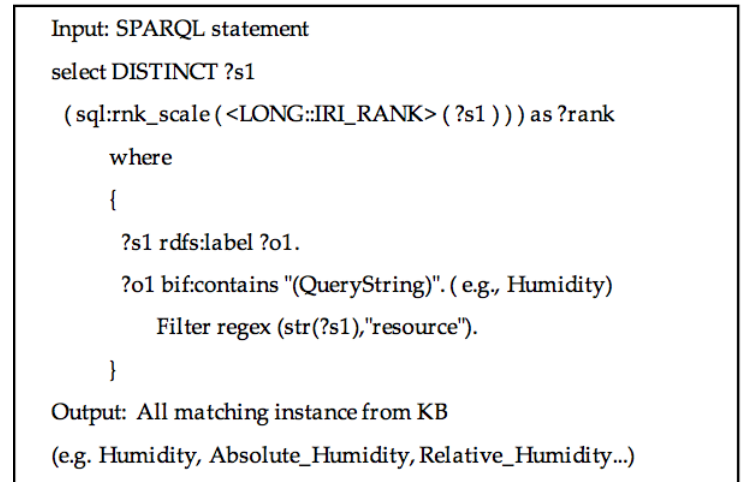
Figure 4. The SPARQL query for generating candidate entities for cell text.